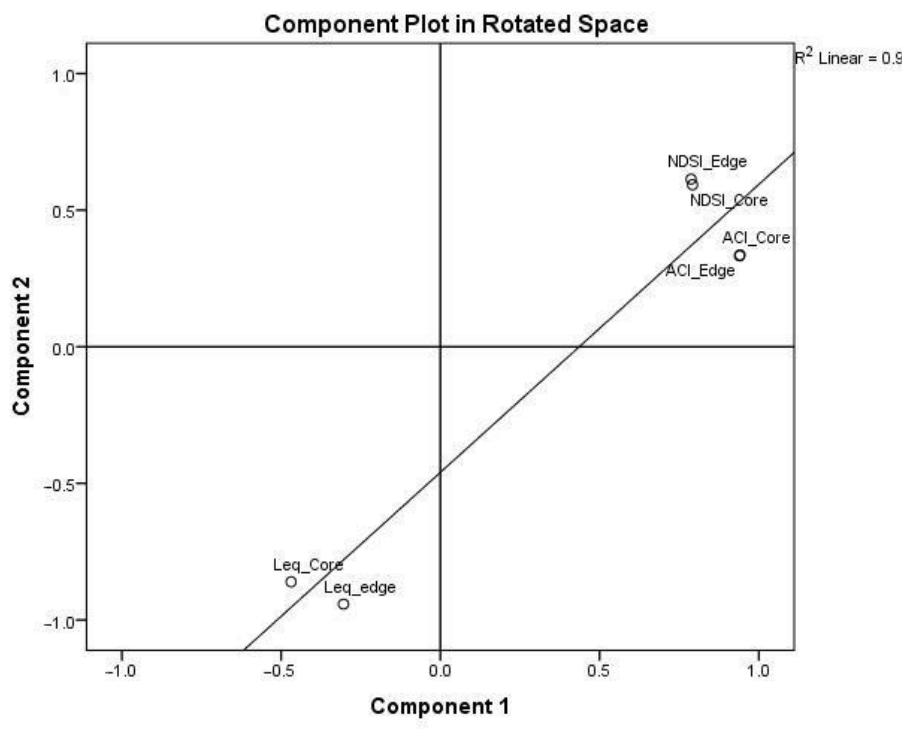
Figure 3. Component plot in rotated space.